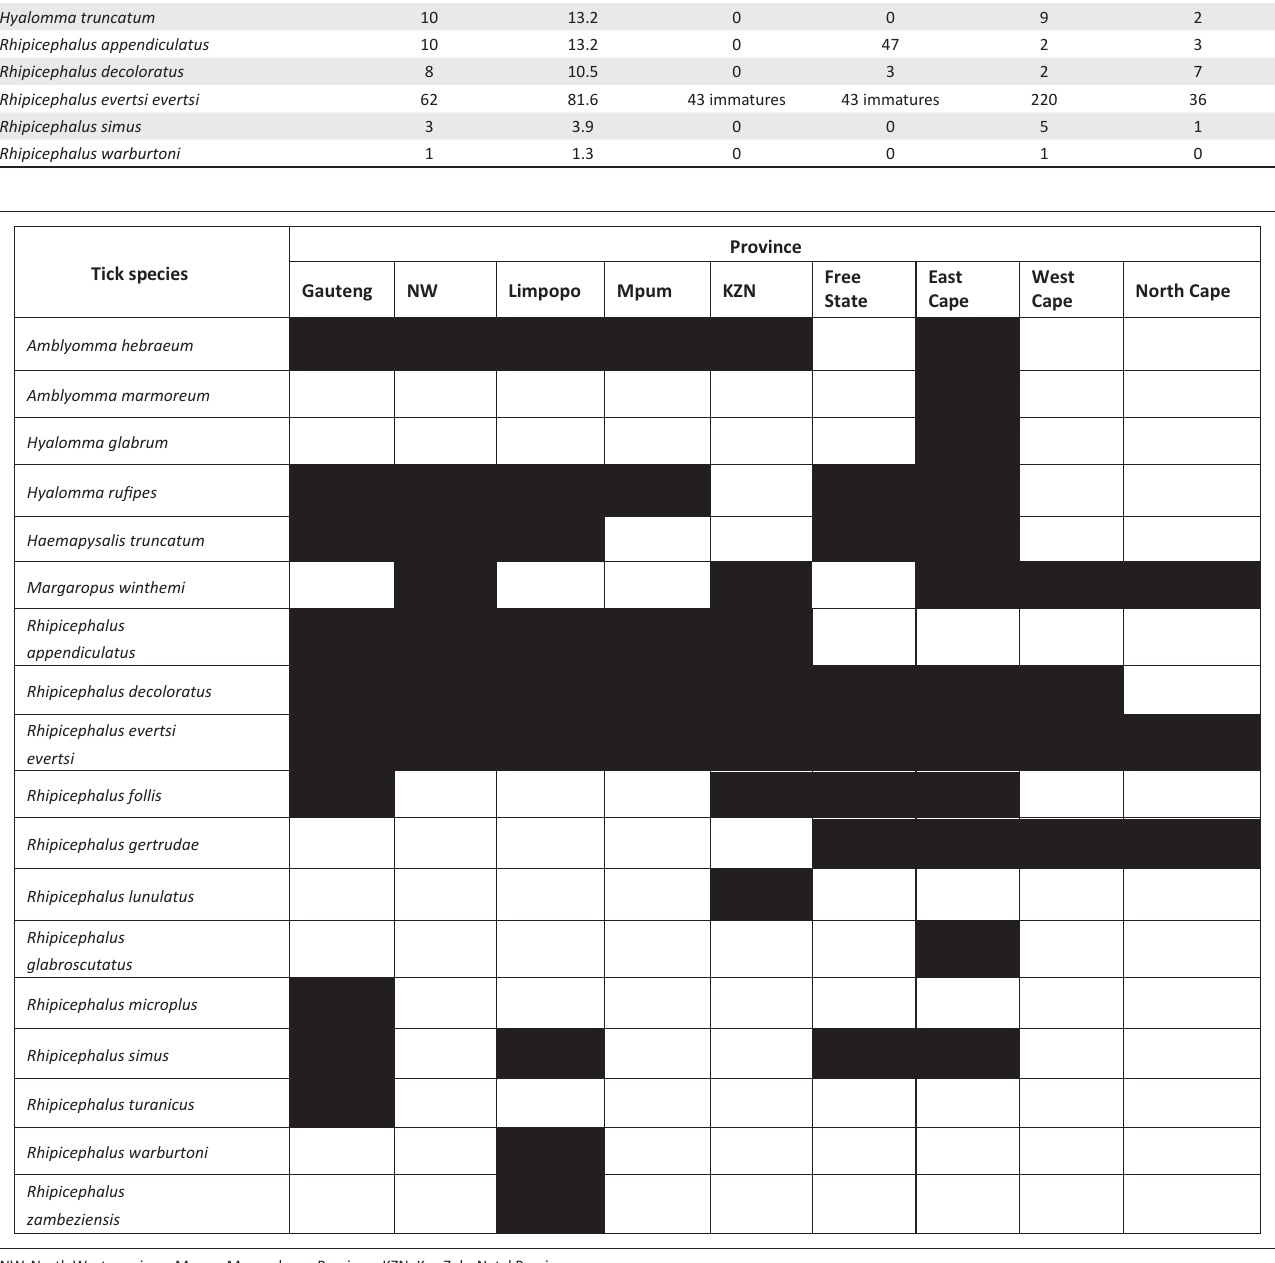
FIGURE 1: The provincial distribution of ixodid ticks that infest horses and donkeys in South Africa.